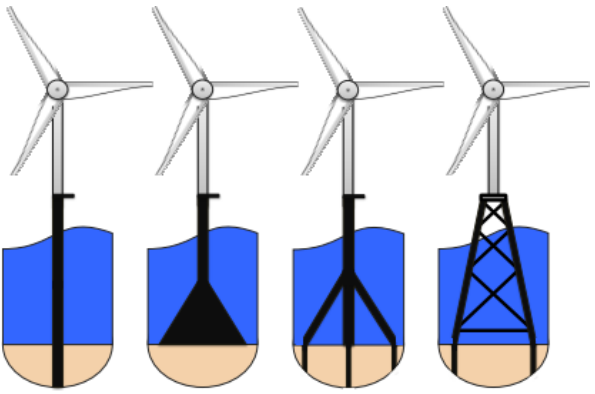
Figure 3. From left to right, a monopile foundation, a gravity-based foundation, a tripod, and a jacket-type foundation (Van der Valk,